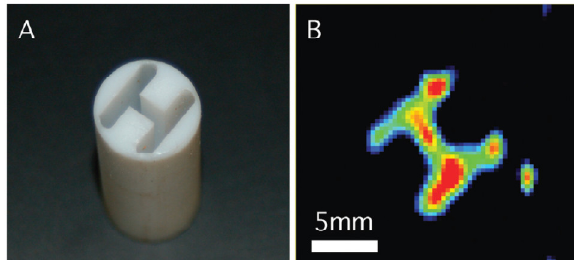
19 of 47 Figure 17. NMR Properties of Si particles. Nuclear spin relaxation ( T 1 ) times at 2.9 T as a function of particle diameter d 0 for various Si particles. Vertical error bars are from exponential fits to relaxation data; horizontal error bars represent the dispersion of size distributions. Inset: Fourier-transform NMR peak amplitude, A, as a function of polarization time for the ball-milled high-resistivity particles with d 0 = 0.17  m. T 1 values were measured using a saturation recovery spin echo pulse sequence. (Reprinted with permission from Reference [11]. © (2009) American Chemical Society).